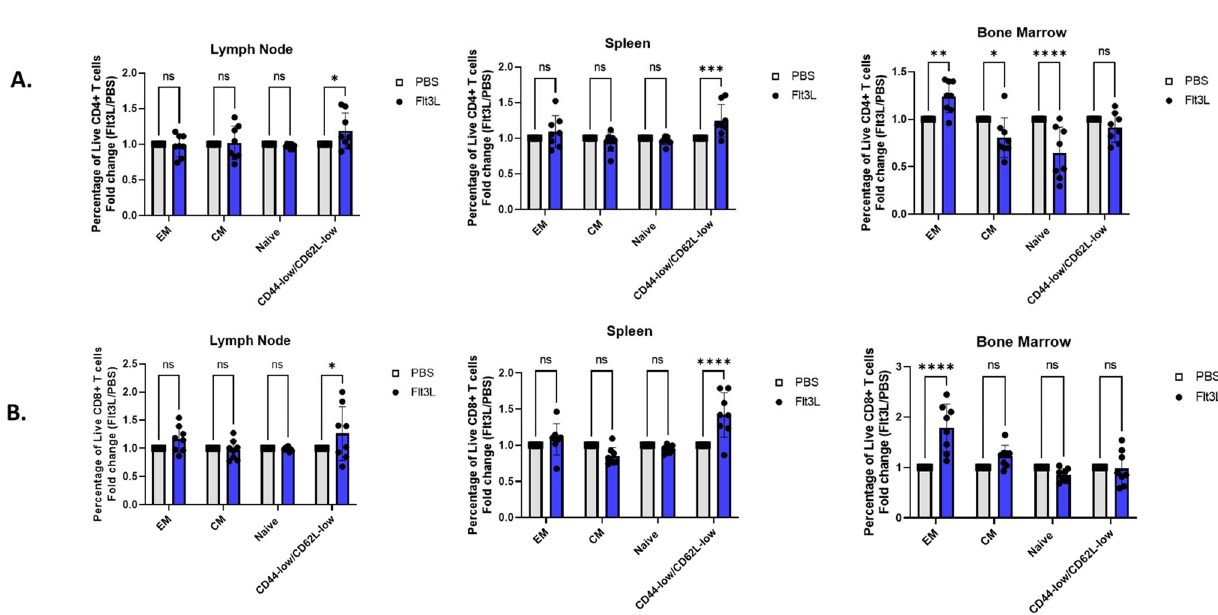
Figure 3. Flt3L affects composition of CD4+ and CD8+ T cell subsets. ( A ) Samples from the LN (left), spleen (middle), and bone marrow (right) were analyzed for memory subtype. CD4 central memory (CM) and effector memory (EM), naïve, and CD44-low/CD62L-low populations were assessed in proportion to respective CD4 total populations. White squares = PBS treated group, Black circles = FL (Flt3L) treated group. (*) indicates statistical significance, P value < 0.05, (**) indicates statistical significance, P value = 0.0077, (***) indicates statistical significance, P value = 0.0007, (****) indicates statistical significance, P value < 0.0001. ( B ) Samples from the LN (left), spleen (middle), and bone marrow (right) were analyzed for memory subtype. CD8 central memory (CM) and effector memory (EM), naïve, and CD44-low/CD62L-low populations were assessed in proportion to respective CD4 total populations. White squares = PBS treated group, Black circles = FL (Flt3L) treated group. (*) indicates statistical significance, P value = 0.0392, (****) indicates statistical significance, P value <